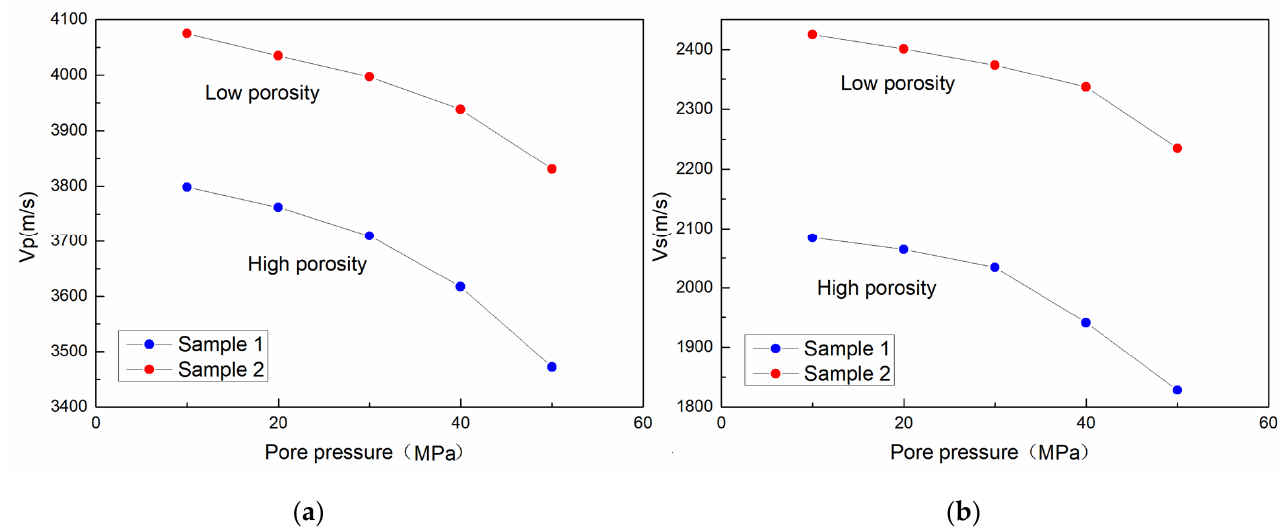
Figure 11. Cross-plot of pore pressure and ( a ) P- and ( b ) S-wave velocity.